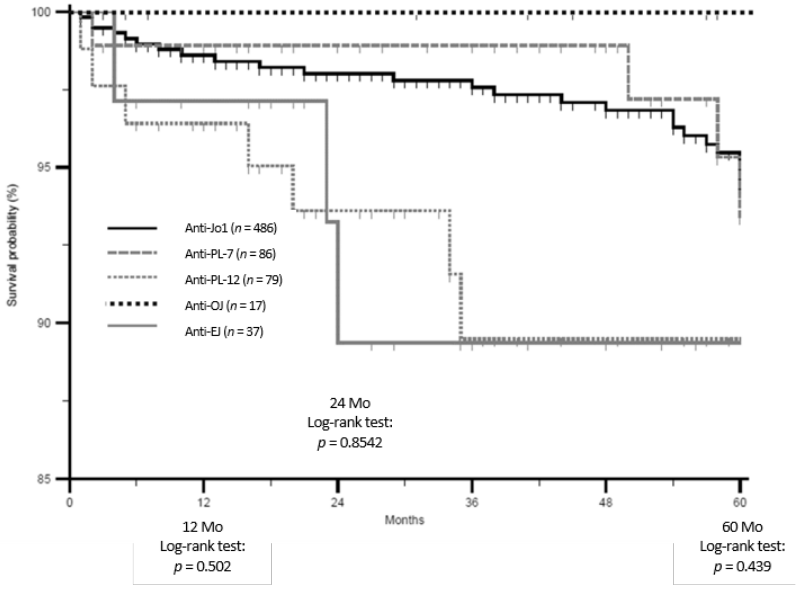
Figure 2. The Kaplan–Meier survival curve in our cohort of antisynthetase syndrome patients (established range: 0–60 months) with Log-rank test at 12, 24 and 60 months. Mo: